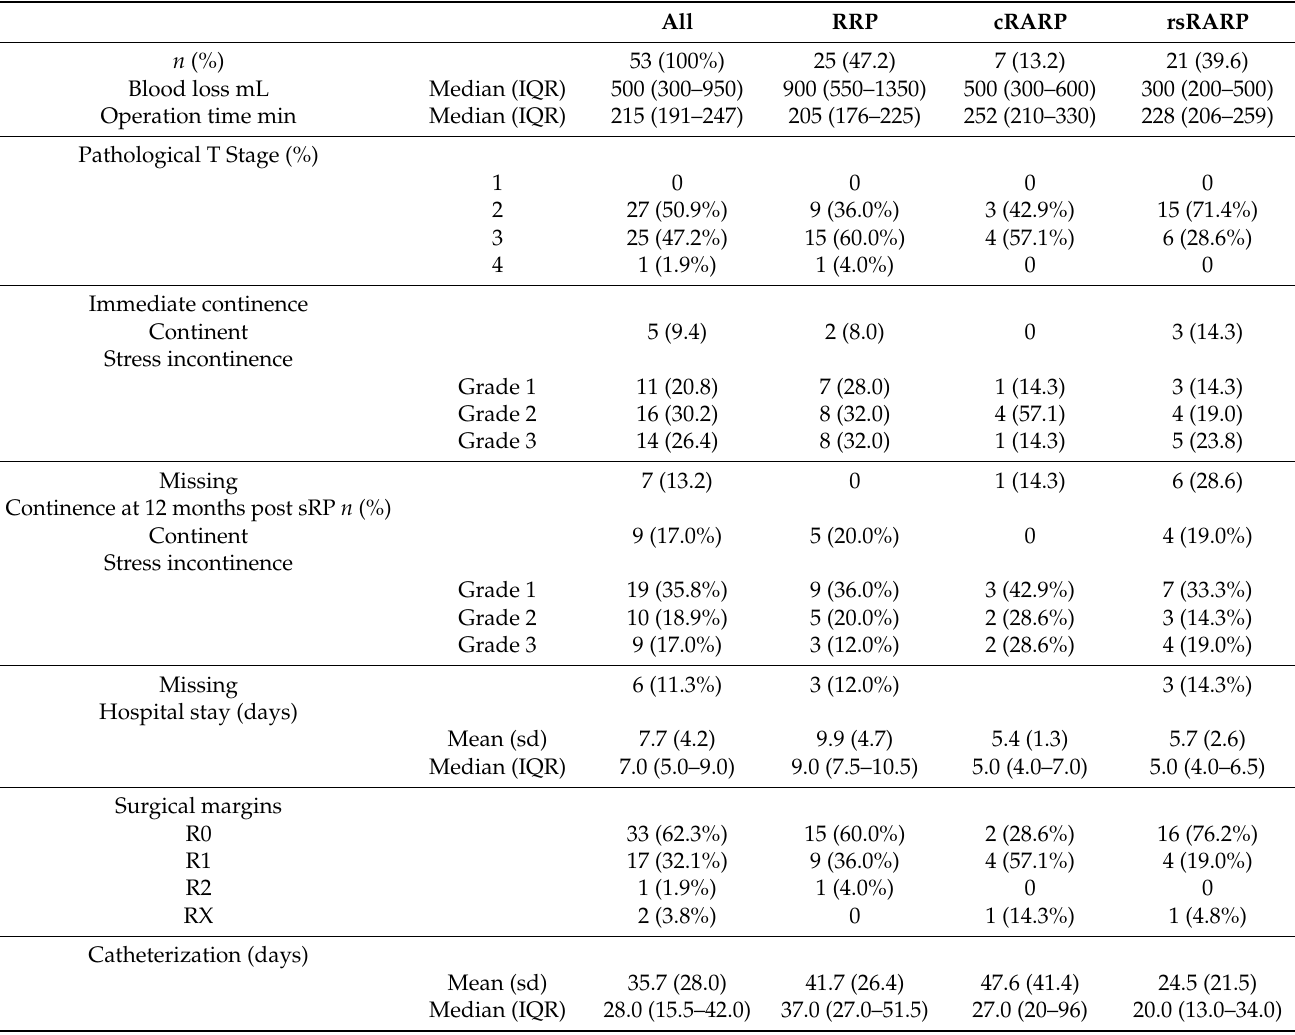
Table 2. Peri- and post-operative